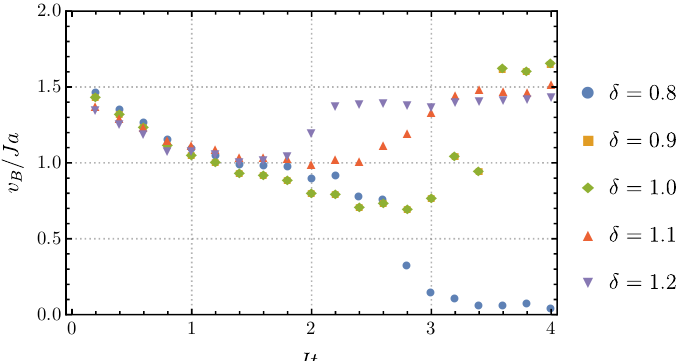
= 1.05 J , h = 0.4 J and β J = 3 for different Figure 6: Fitted butterfly velocity at h X Z = 4.4 and a = 1). For small t hyperparameters δ and t ( J t , fluctuation with 0 1 0 respect to δ is insignificant due to a larger amount of data. However, at these early > 2 the times there is a systematic error leading to a dependence on t . When J t 0 0 fitting is not stable. The optimal choice of hyperparameters, from the figure, would ≈ 1.5 with δ ≈ be J t 0